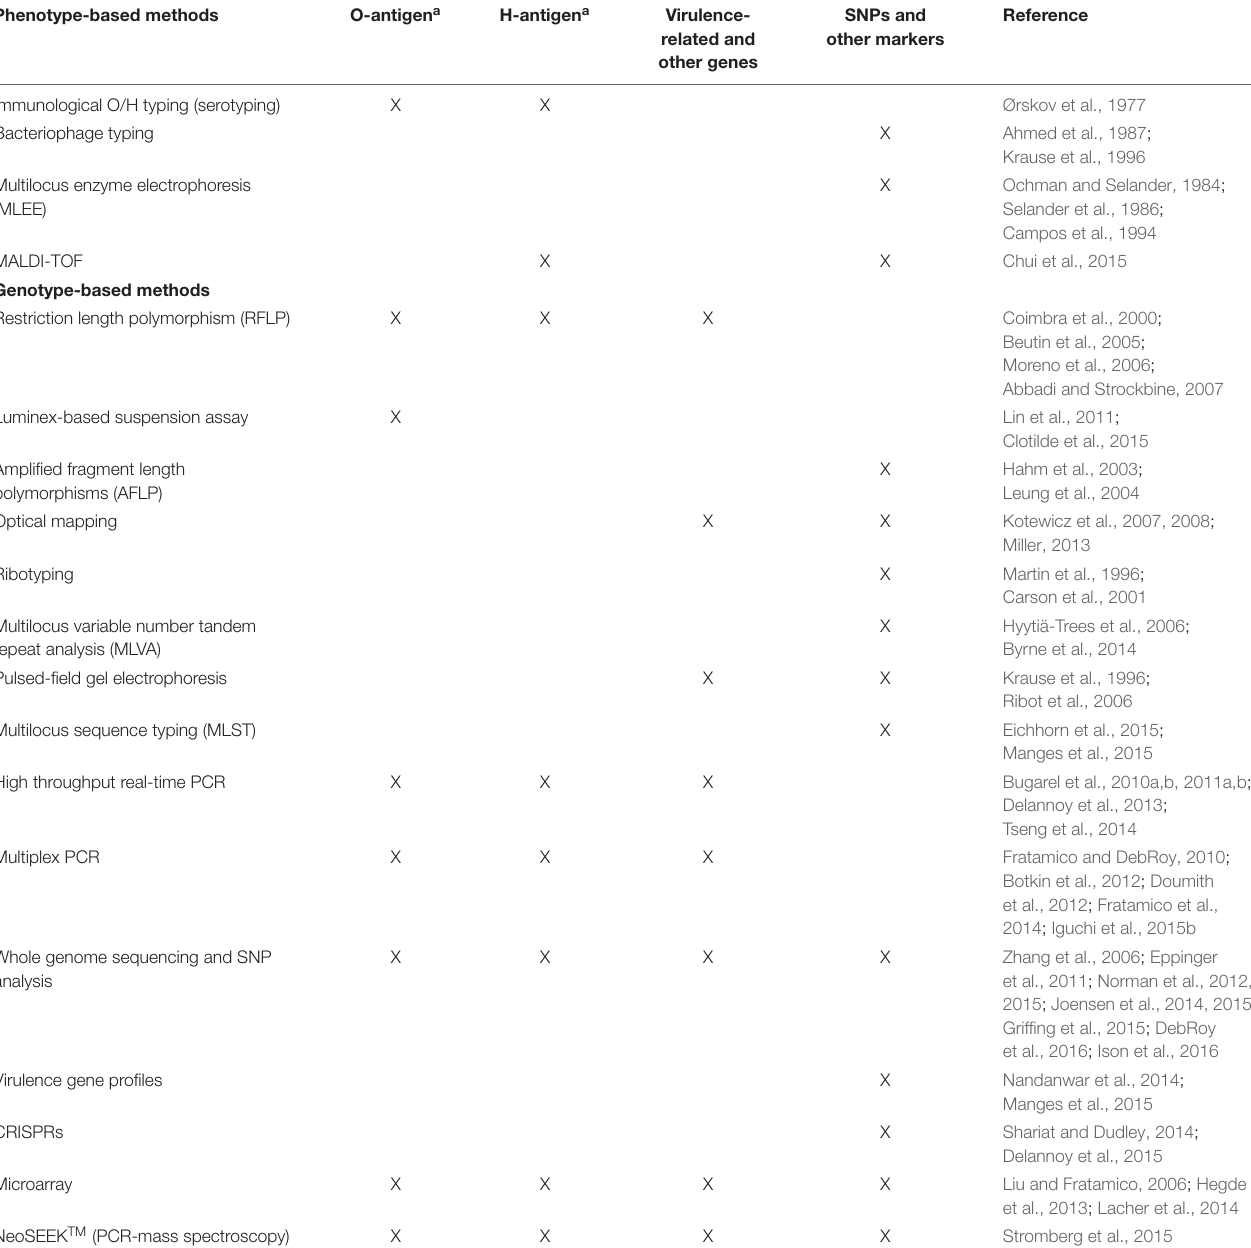
TABLE 1 | Phenotype- and genotype-based methods for subtyping and molecular serotyping of E. coli